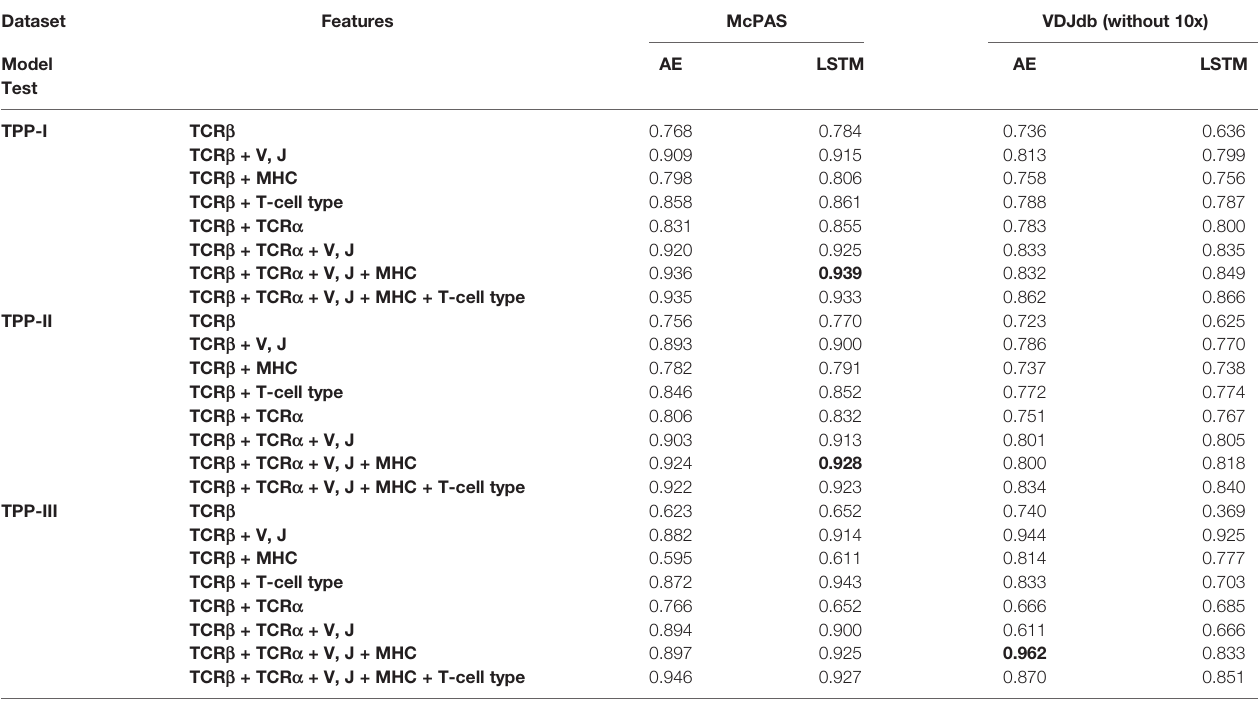
TABLE 4 | Area Under Curve (AUC) of TCR-Peptide Pairing (TPP) prediction tasks with either known peptide or TCR (but unknown pairing, TPP-I), known peptide unseen TCR (TPP-II), and unseen peptide and TCR (TPP-III). Dataset